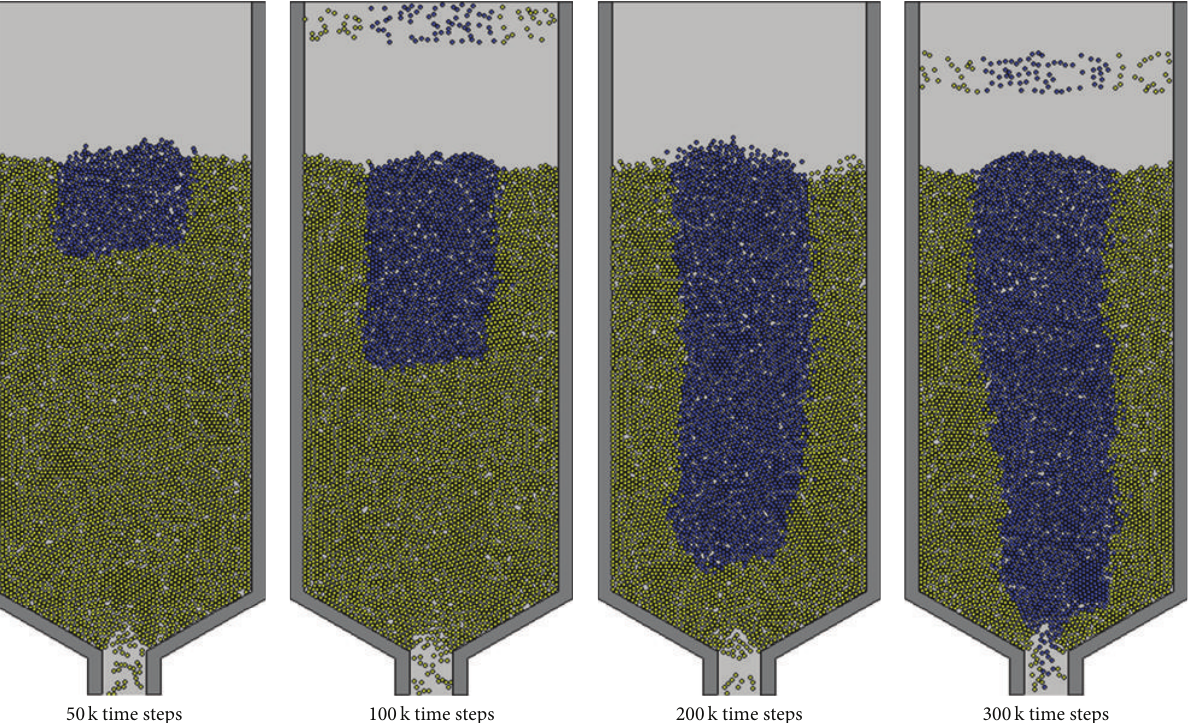
Figure 3: Distribution of fuel and graphite pebbles in the reactor at different time steps with funnel angle of 30 ∘ and particle number ratio of : 𝑁 𝑁 𝑓 𝑔 = 2 :